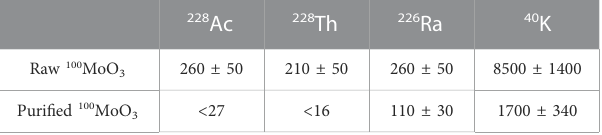
TABLE 3 Values and 90% C.L. upper limits on 228 Ac, 228 Th, 226 Ra, and 40 K in the raw and puri fi ed 100 MoO 3 powders in units of μ Bq/kg. The decision to report values or limits is determined using statistical errors only, while the reported results include systematic